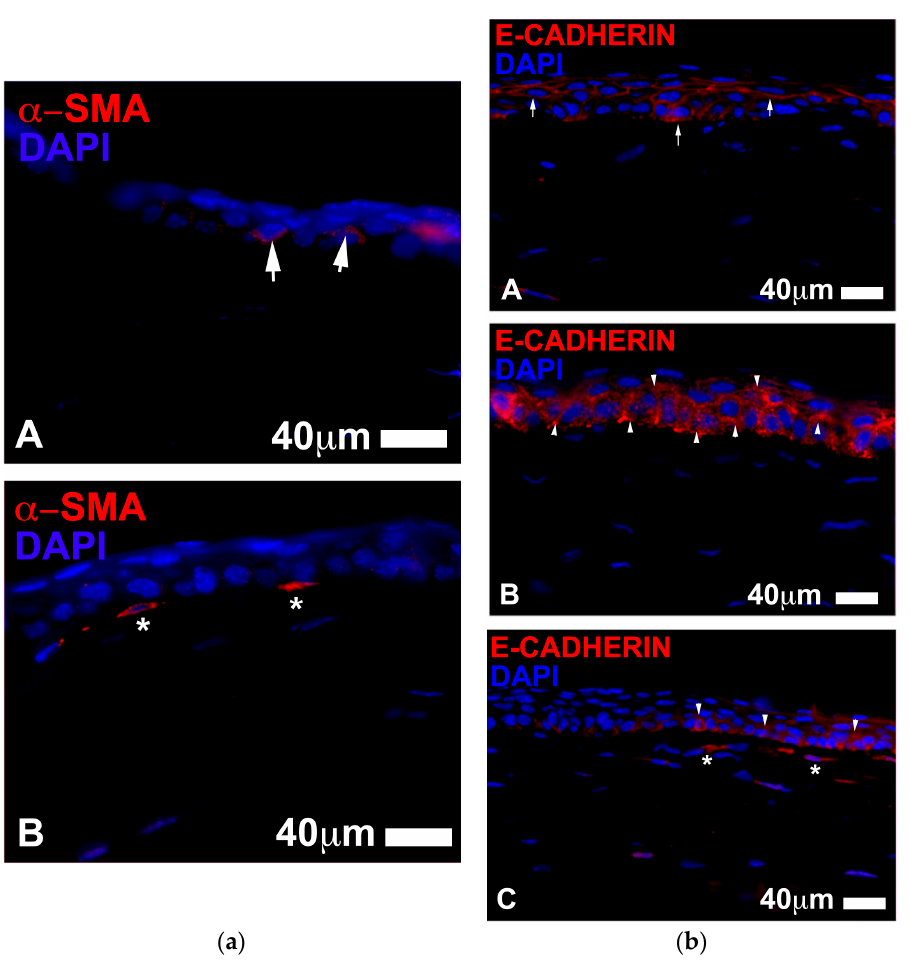
Figure 6. ( a ) ADSC treatment ( A ) seemed to retard the onset of myofibroblast appearance when compared to the controls eyes ( B ) during the initial stages of the wound healing process (three days after injury). There tended to be scarce or no myofibroblasts in the stroma in the ADSC treated eyes; only a diffuse staining for α -SMA (in red arrows) was visible in the basal cells of the central epithelium ( A ). In contrast, several α -SMA + myofibroblasts (shown as elongated cells stained in red asterisks) were present in the upper stroma of the control eyes (Scale bars: 40 µm). ( b ) E-Cadherin staining (in red) 7 days after injury. E-Cadherin appeared to be located bordering the epithelial cells and rarely accumulated in the cytoplasm in the ADSC treated eyes ( A ). The control corneas showed a different staining pattern for E Cadherin, which accumulated in the cytoplasm of the epithelial cells ( B ). A similar location of epithelial E-Cadherin was found in the basic serum treated eyes, which tended to accumulate in the cytoplasm of the basal cells ( C ). There also appeared to be more E-Cadherin + cells in the stroma of the basic serum treated eyes. (Scale bar 40 µm).